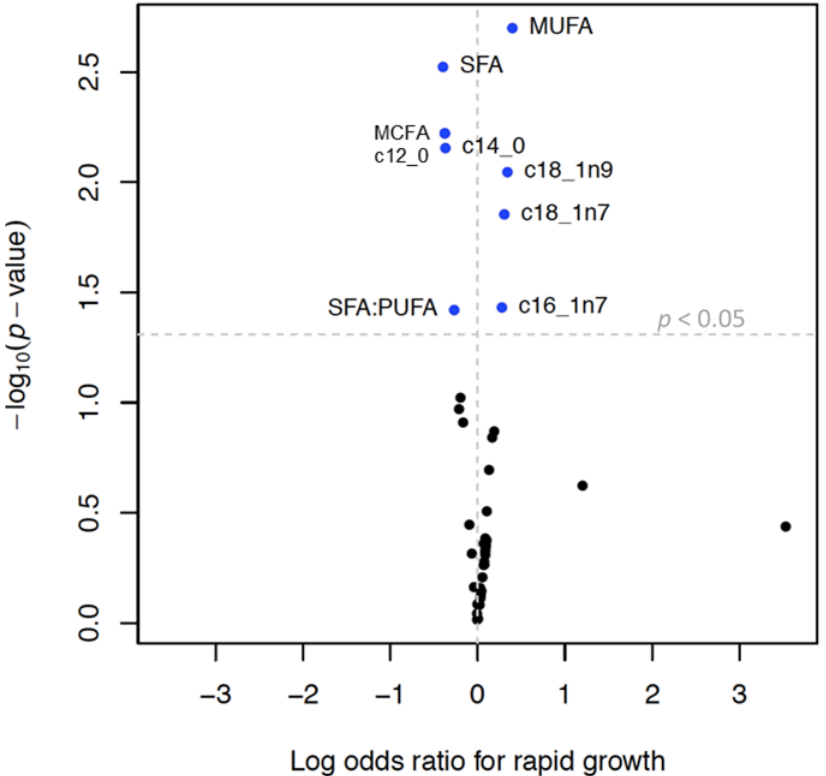
Figure 4. Volcano plot 1 showing associations 2 between triglyceride fatty acid (TGFA) composition in milk and rapid growth 3 Legend: 1 Each dot represents change in the log of the odds ratio (OR) for rapid growth (x axis) per interquartile range (IQR) increase in TGFA. Y-axis represents the − log 10 of the p -value. The vertical dotted line represents an OR of 1 and the horizontal dotted line represents a p -value of 0.05, so that dots above that line represent associations that have a p -value < 0.05. 2 Models were run in the multiply imputed data set ( n = 789) in 10 imputed sets and adjusted for maternal age, smoking, education, pre-pregnancy body mass index, gestational weight gain, parity, and child sex. 3 Defined as change in weight-for-age z-score between 0 and 6 months > 0.67.